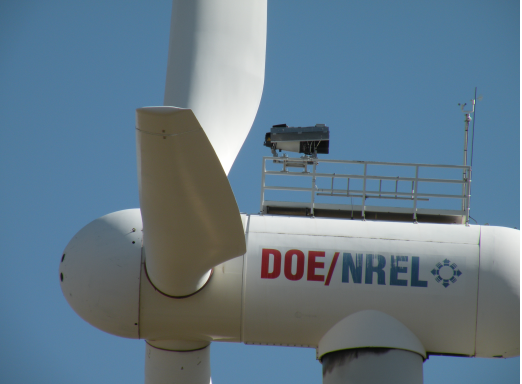
Figure 1. The SpinnerLidar with its mounting platform mounted on the nacelle of the research turbine CART3 at the National Renewable Energy Laboratory (NREL), Colorado, USA. Photo courtesy of Marijn Floris van Dooren.